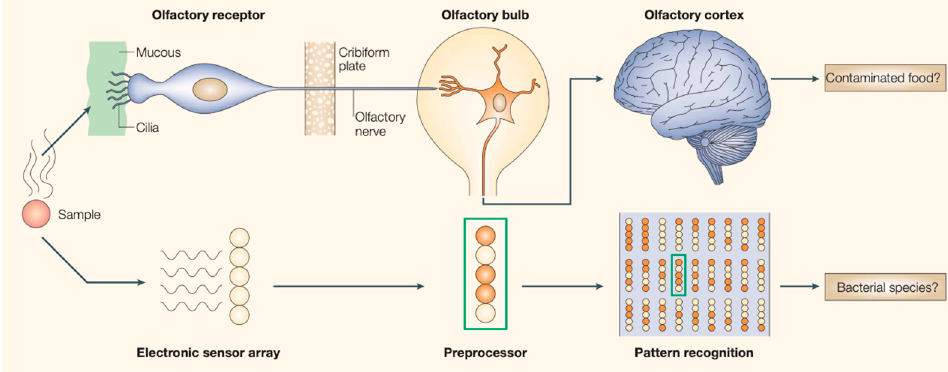
Figure 1. An analogy between human olfactory system and E-nose [33].